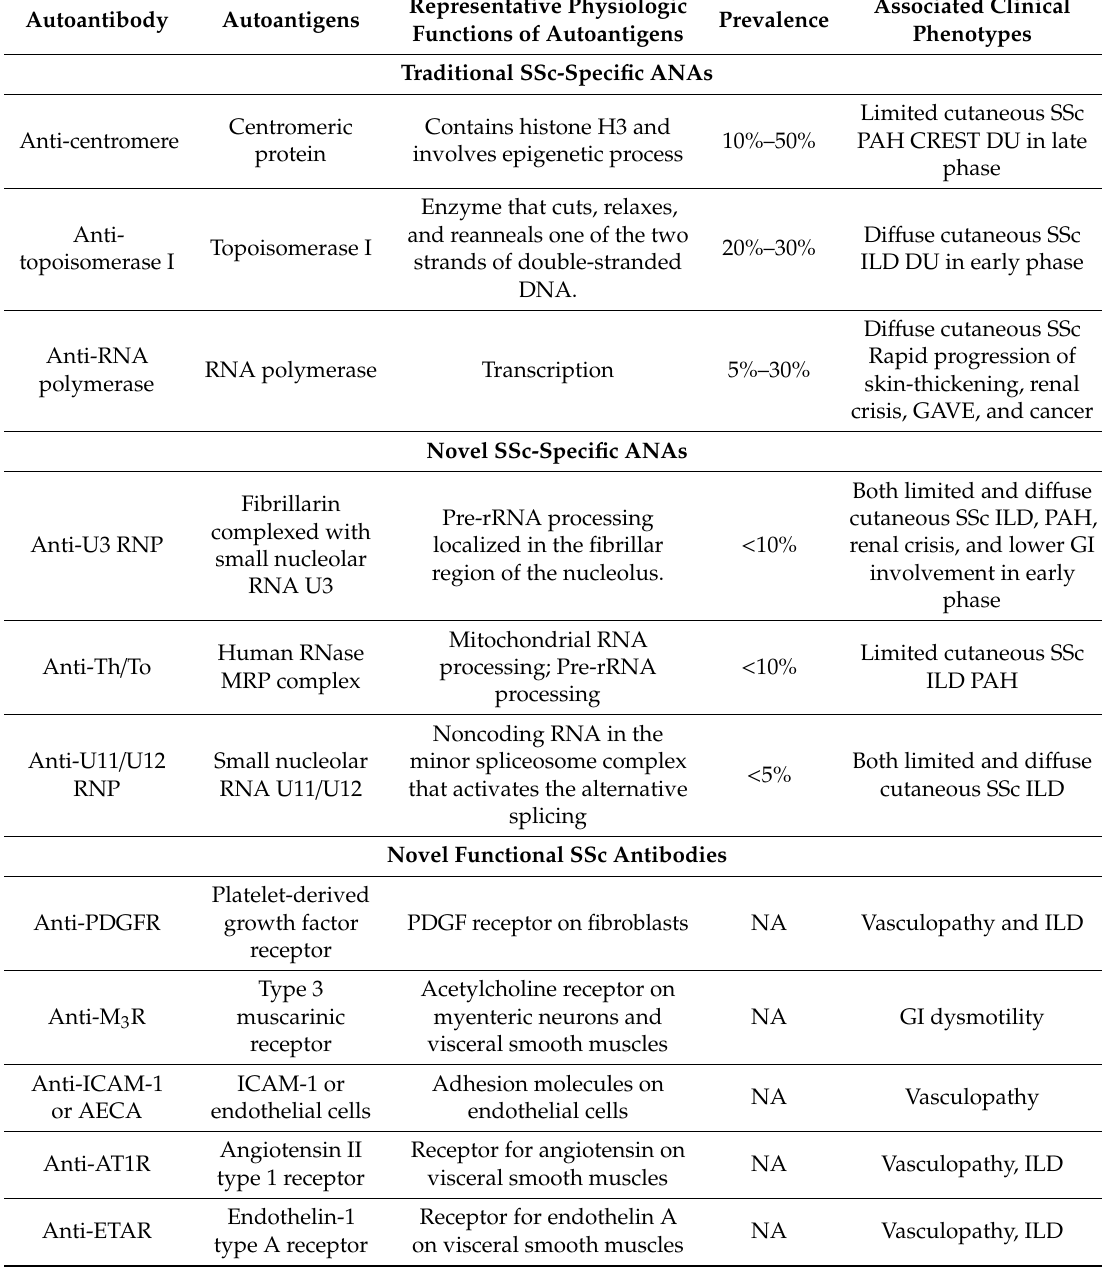
Table 2. Summary of scleroderma-related